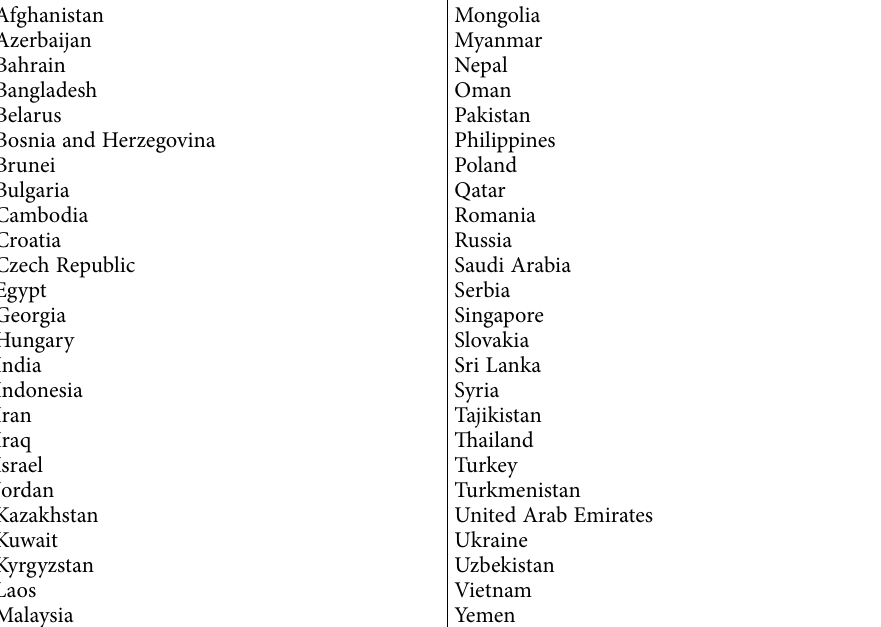
Table A1. The BRI countries observed in this